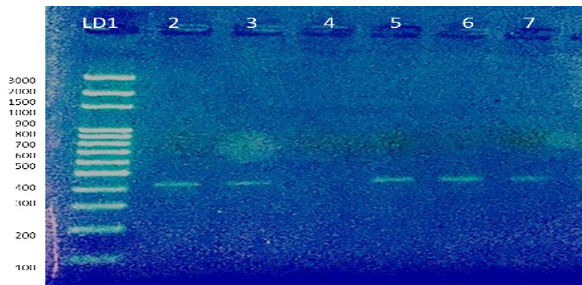
Fig. 2. Gel Electrophoresis (1.5% agarose) of ITS2 gene (400bp) using 100bp DNA ladder and Diamond TM Nucleic Acid Dyeto (LD1=DNA ladder; Lane (2, 3, 5, 6, and 7) =positive results; Lane 4=negative result (100 volt for one hour)